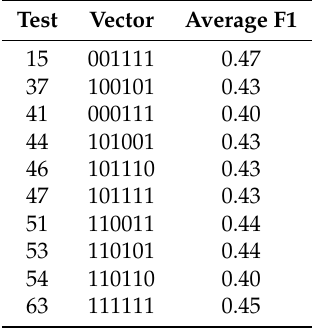
Table 10. Zeus Dataset—Highest Performing Feature